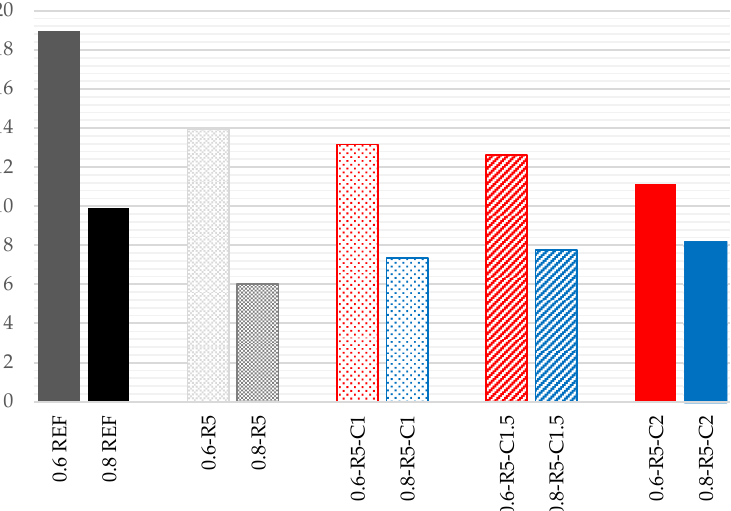
Figure 5. Results for compressive strength (MPa).